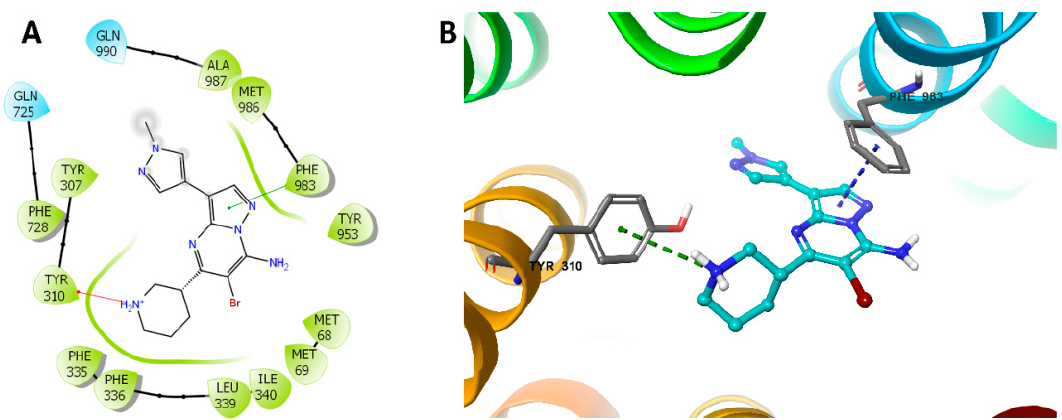
Figure 6. Docking study of MK-8776 with human P-gp. ( A ) The generated 2D figure of the docked position of MK-8776 within the P-gp crystal. The polar residues are indicated with cyan bubbles, and the hydrophobic residues are indicated with green bubbles. Furthermore, the cation– π bond in the figure is shown as red arrow, and the π – π interaction is shown as green line. ( B ) The enlarged 3D figure of the docked position of MK-8776 within the drug-binding site of human P-gp. The structure of MK-8776 is shown as a ball and stick mode with the atoms colored as follows: carbon with cyan, nitrogen with blue, bromine with dark red. The important residues of P-gp are shown as sticks, with the atoms colored as follows: carbon with grey, nitrogen with blue, oxygen with red, hydrogen with white. The cation– π bond is indicated with green dotted line. The π – π stacking interactions are indicated with a blue dotted line.